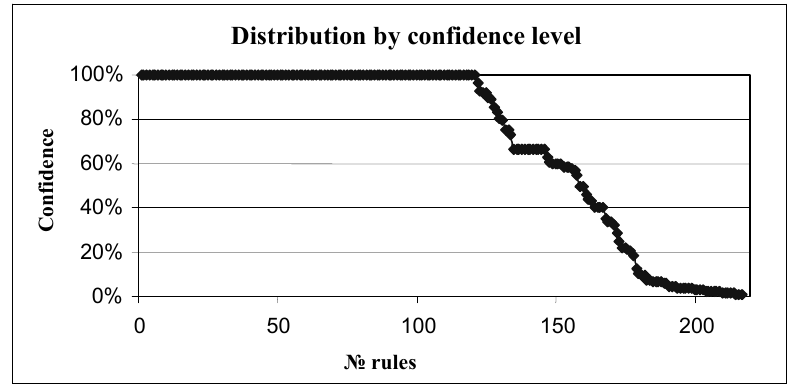
Figure 5. Association of system-detected rules with the confidence level.